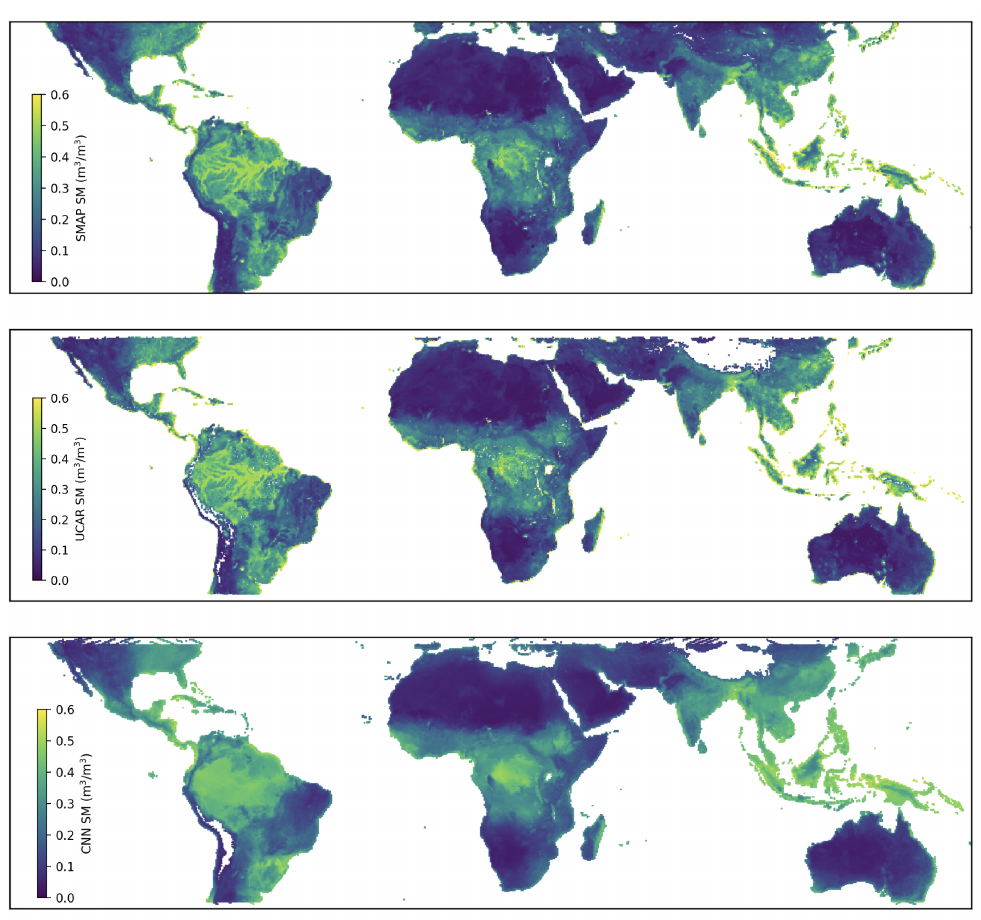
Figure 12. Global soil moisture from SMAP ( top ), UCAR ( middle ), and the neural network ( bottom ), averaged over late 2018–2019 to 36 km grid cells, shows similar large-scale